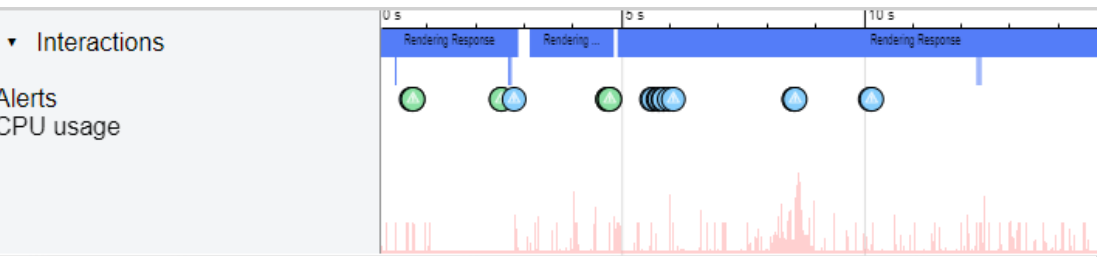
Figure 9. Power consumption while application is running for 10